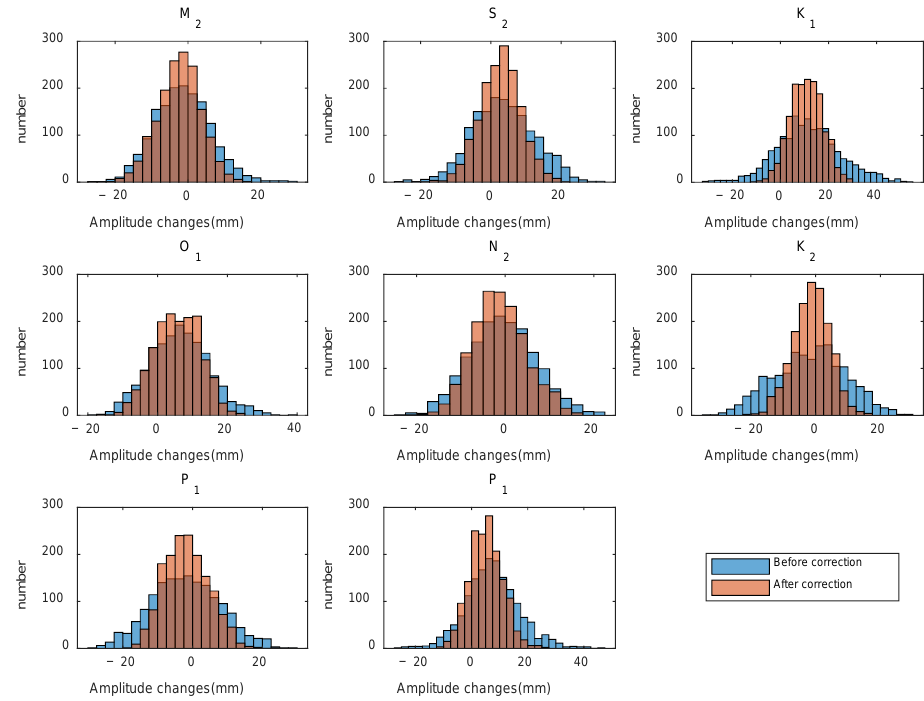
Figure 11. Histogram of amplitude change before and after the MVC based on T/P-Jason data. Table 8. The extreme values of amplitude changes before and after the MVC of the eight major constituents in the South China Sea.